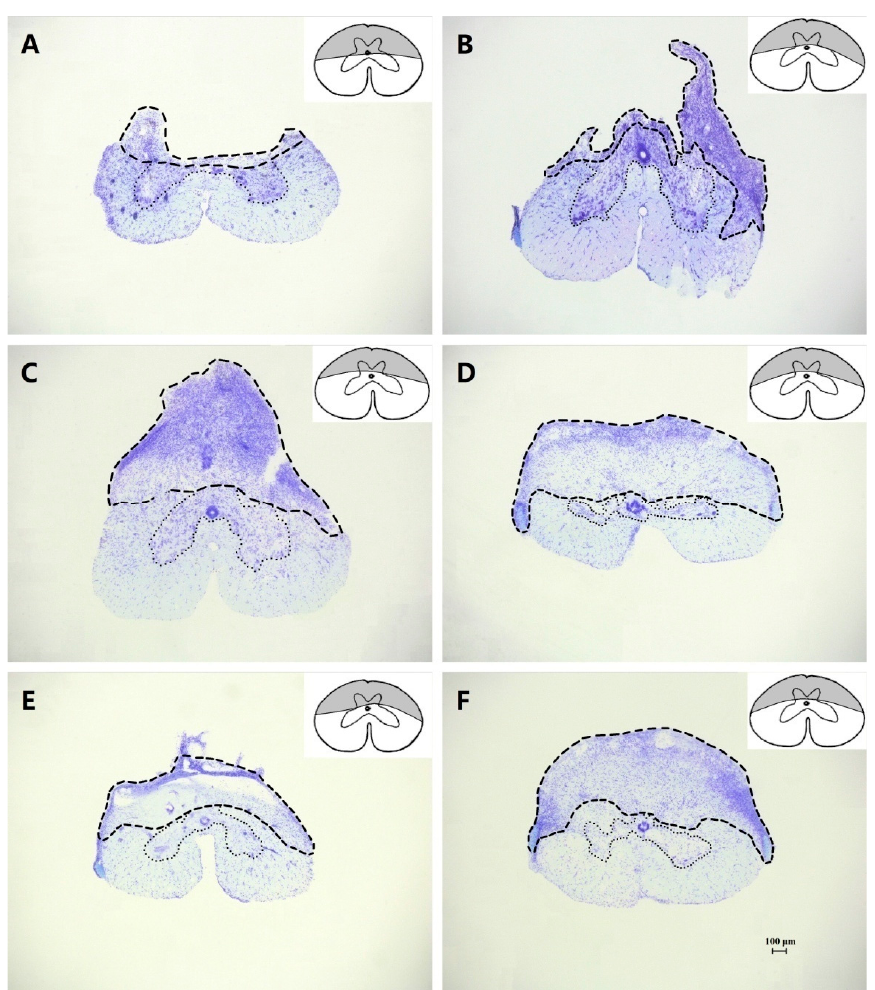
Figure 3. Photomicrographs and the corresponding schematic drawings of transverse sections, showing the extent of the spinal cord damage with dorsal lesions in individual geckos. Scale bar = 100 μ m for all. In the photomicrographs, the lesioned area is delimited by broken lines, and the intact gray matter by dotted lines, with the remainder corresponding to the intact white matter. In the schematic drawings, the damaged area is shaded.